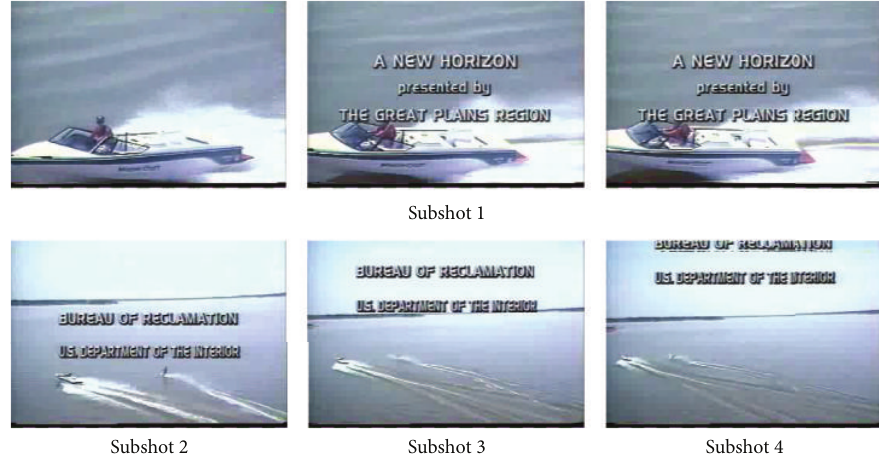
Figure 8: Key-frames extracted from BOR10 013 .